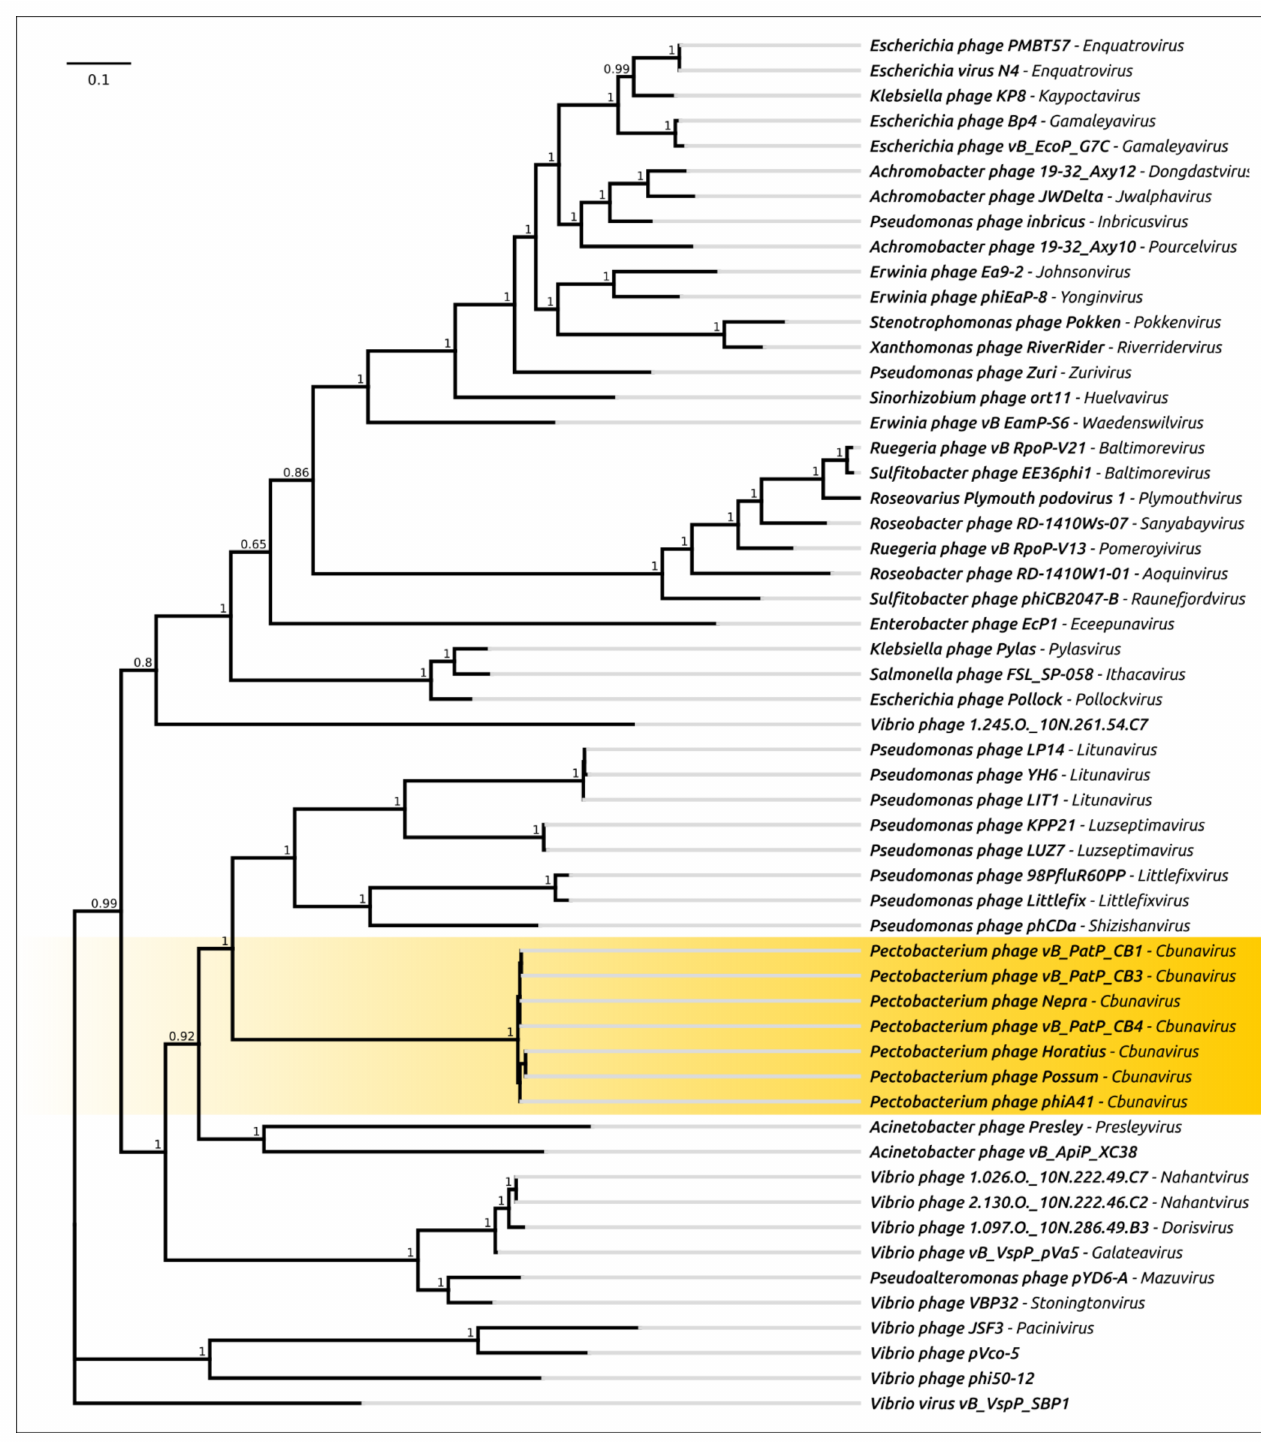
Figure 10. Phylogenetic tree obtained with MrBayes, based on the terminase large subunit amino acid sequences of Schitohiviridae phages. Bayesian posterior probabilities are indicated near their branches. Taxonomic classification is shown to the right of the phage name. The scale bar shows 0.1 estimated substitutions per site and the tree was rooted to Vibrio phage vB_VspP SBP1. The chain length was 2,200,000, the burn-in length was 200,000, the subsampling frequency was 200 and the average standard deviation of split frequencies was 0.0017. The SRP bacteriophage clade is